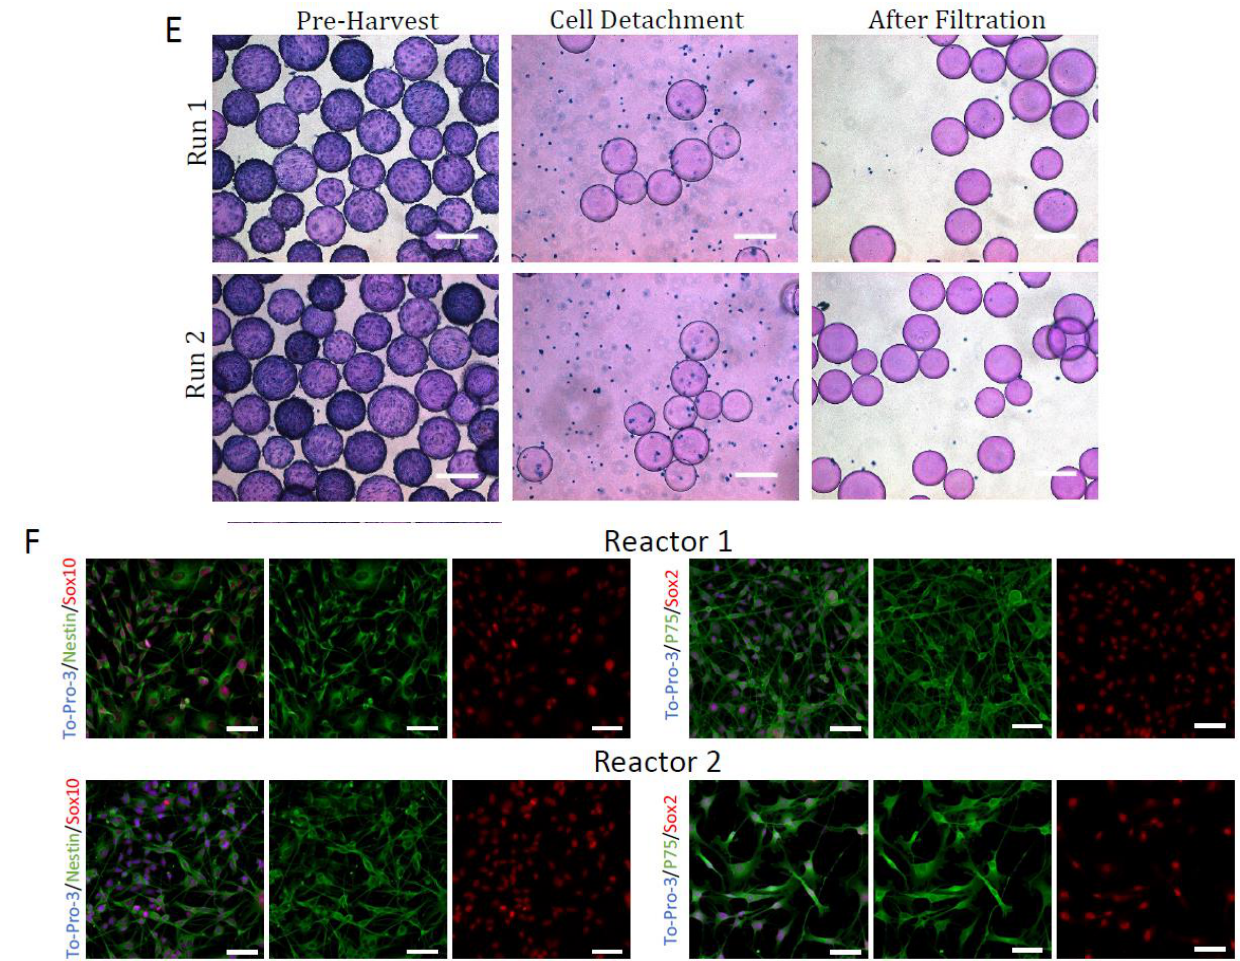
Figure 5. Full vessel harvest of Sk-SCs expanded in 500 mL DASGIP bioreactors, and efficiencies for each harvesting step. ( A ) Cell-microcarrier detachment efficiency, ( B ) cell filtration efficiency, ( C ) centrifugation efficiency, ( D ) overall cumulative harvest efficiency. ( E ) Photomicrographs taken before harvest, following enzymatic detachment, and after final filtering. ( F ) Immunophenotype of harvested Sk-SCS. The harvested Sk-SCs were stained for expression of characteristic markers Sox10, Sox2, P75, and nestin. Scale bars represent 200 µ m. Error bars represent one standard deviation of the